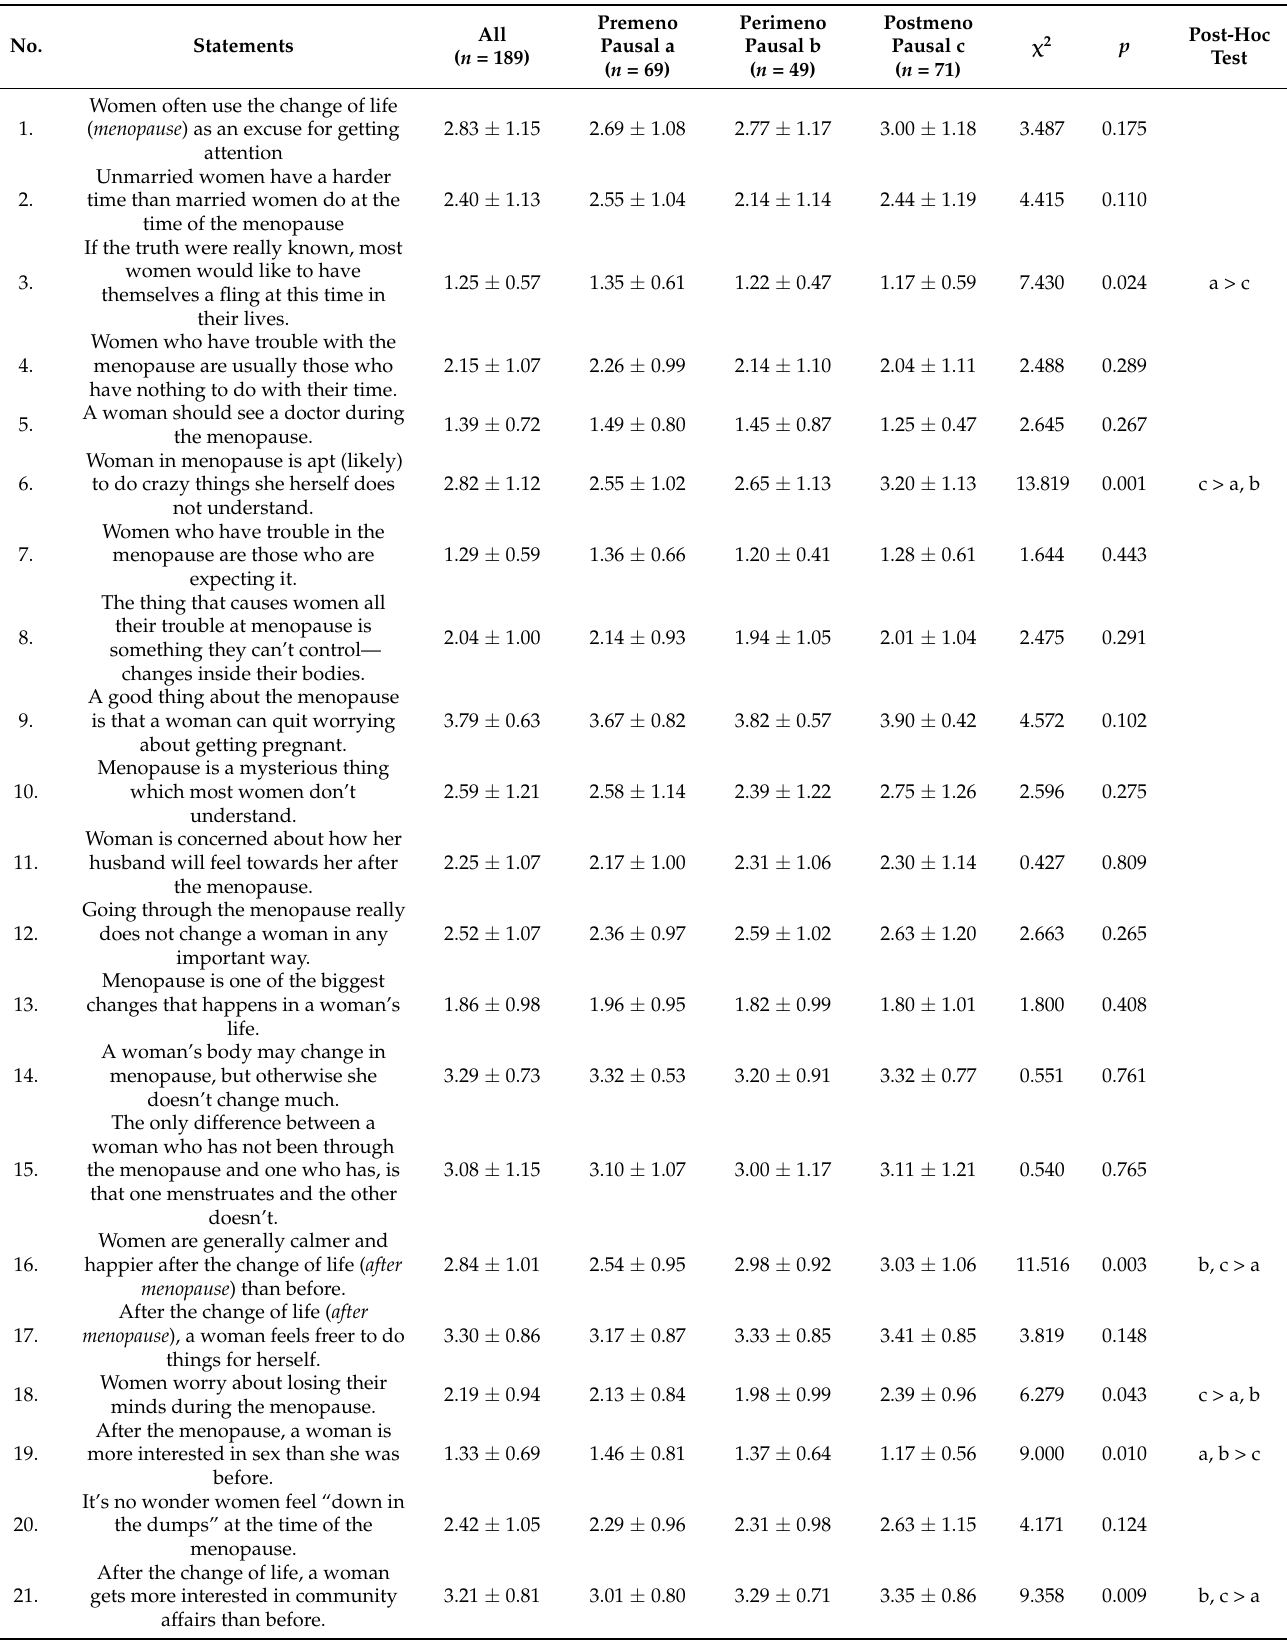
Table 2. Mean attitude towards menopause by menopausal status